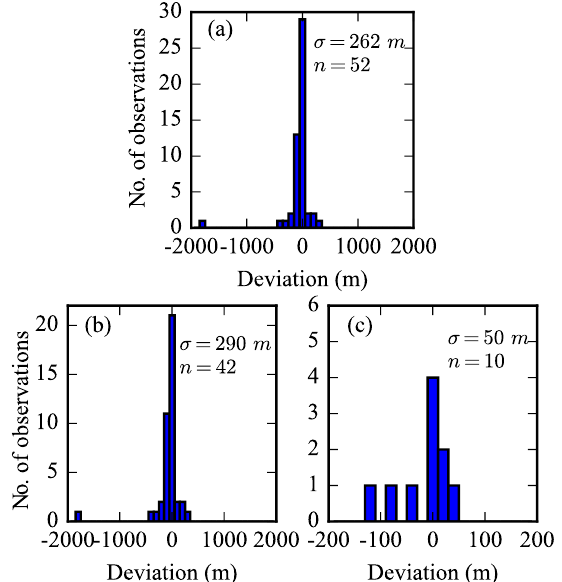
Figure 5. Locational errors in x/y coordinates of all tweets (a) , only the ones referring to streets (b) and only the ones referring to point locations (c) .